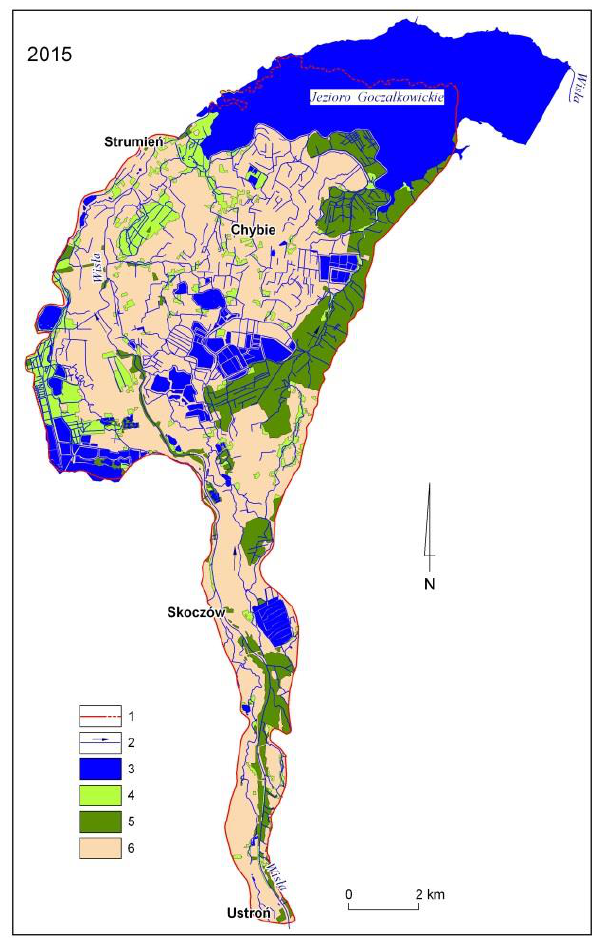
Fig. 6. Modern types of land use in the River Little Vistula alluvial fan area 1 - border of the research area, 2 - river network, 3 - water reservoirs, 4 - meadows and pastures, 5 - forests and shelters, 6 - agricultural land and dispersed